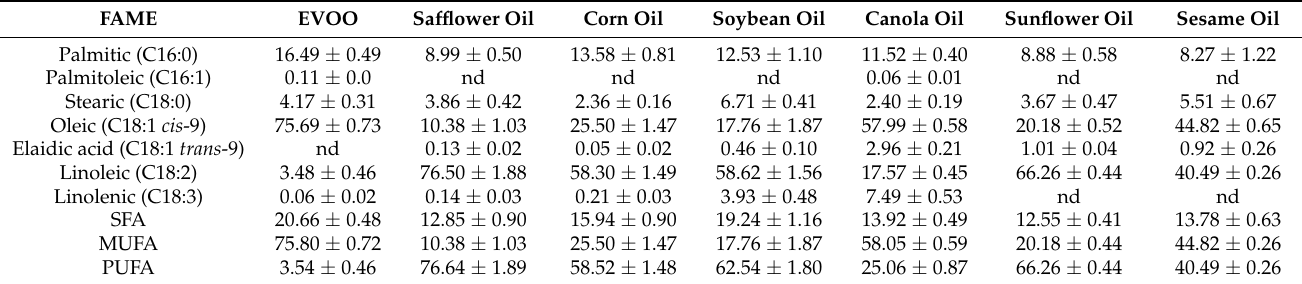
(Figure 3a), while the other vegetable oils are predominated by polyunsaturated fatty acids, mainly C18:2 (Table 1). Table 1. Individual fatty acids and total SFA, MUFA and PUFA composition of EVOO and other edible oils as determined by GC-MS